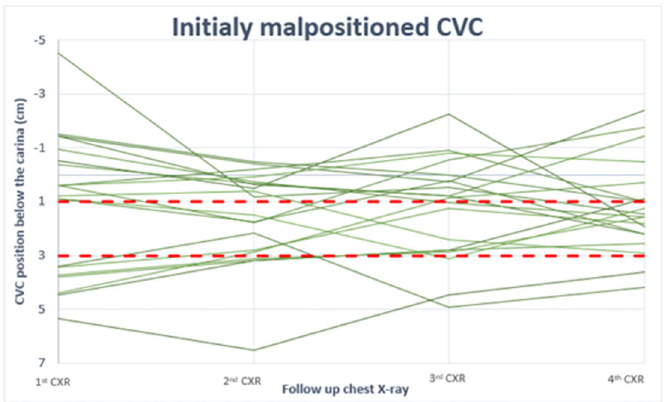
Fig 4. Tip position below the carina as shown in CXR (after insertion, 1 st , 2 nd , and 3 rd ) for initially mal-positioned catheters. CVC (Central Venous Catheter),